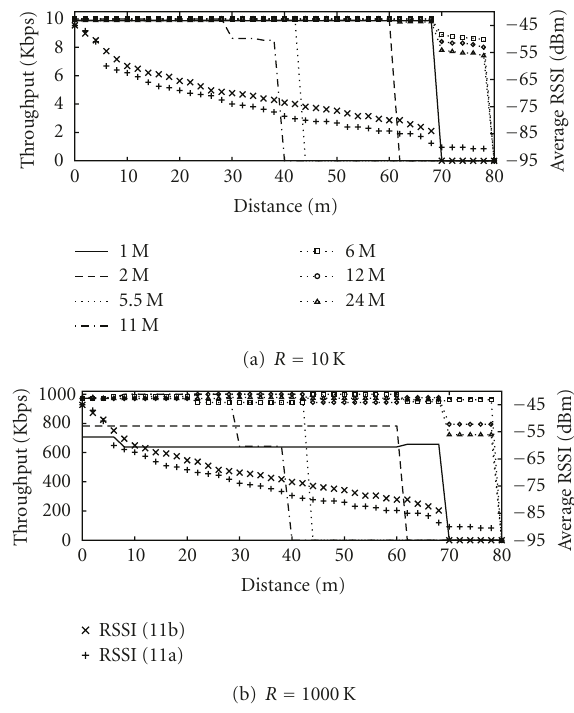
Figure 7: Throughput and RSSI versus distance.